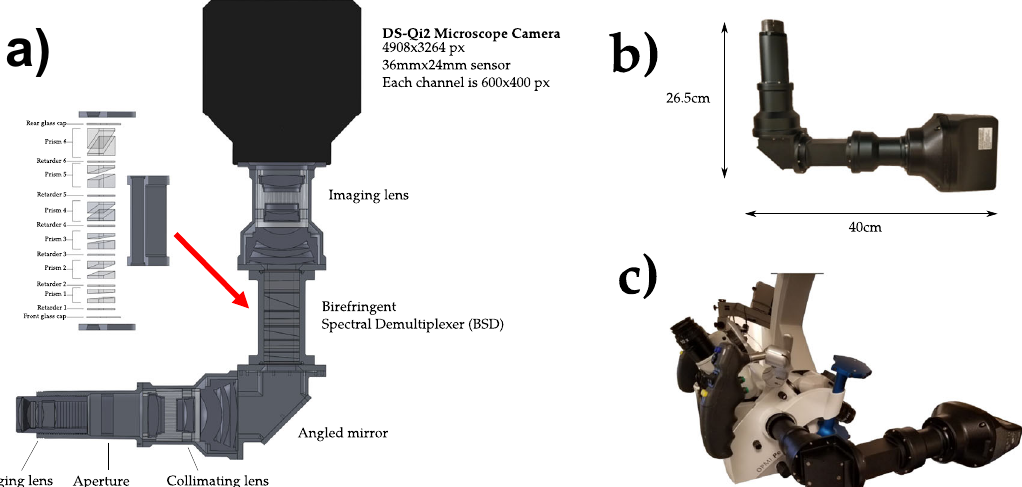
Fig. 7 IRIS component diagram and system dimensions. a Internal components and optics modeled for the IRIS. b Final dimensions of the system. c IRIS mounted on the Pentero surgical